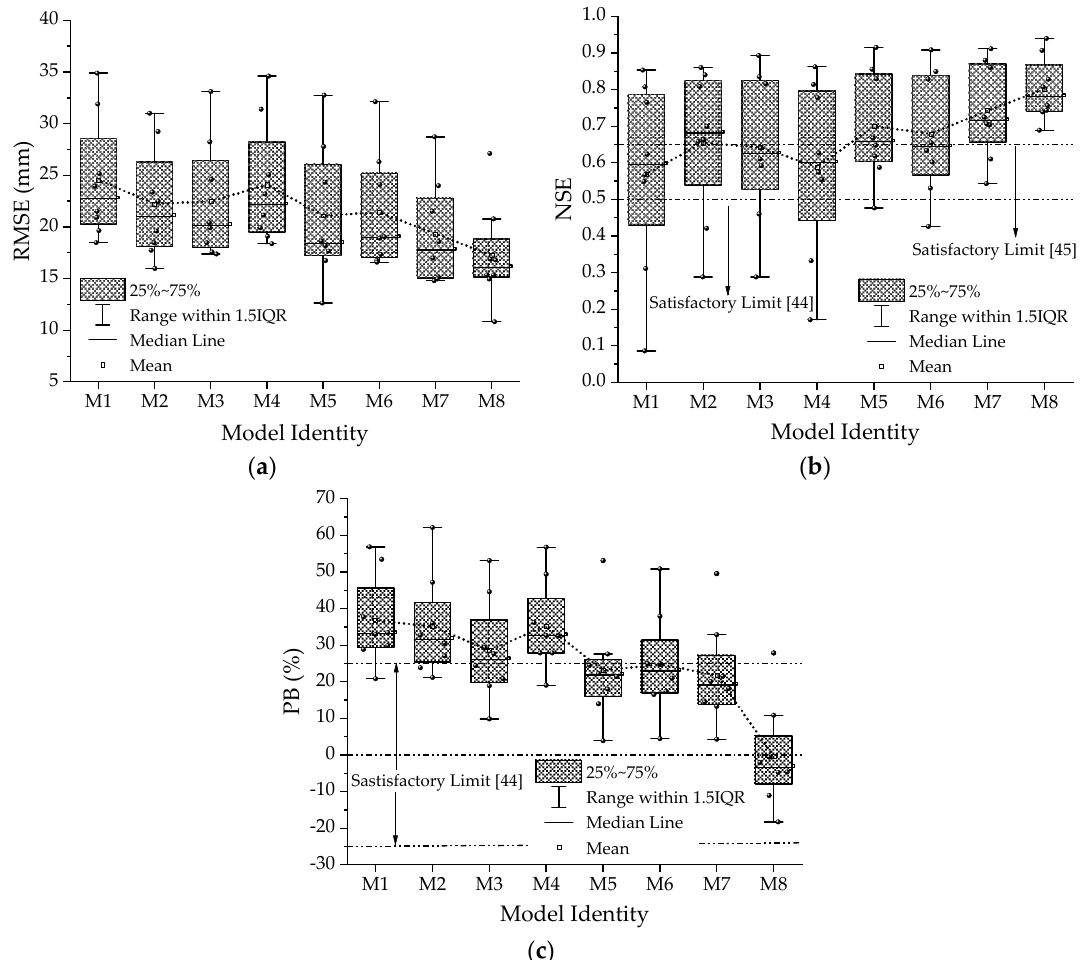
Figure 3. ( a ) RMSE, ( b ) NSE, and ( c ) PB for eight variants of the CN model using data of eight validation watersheds.